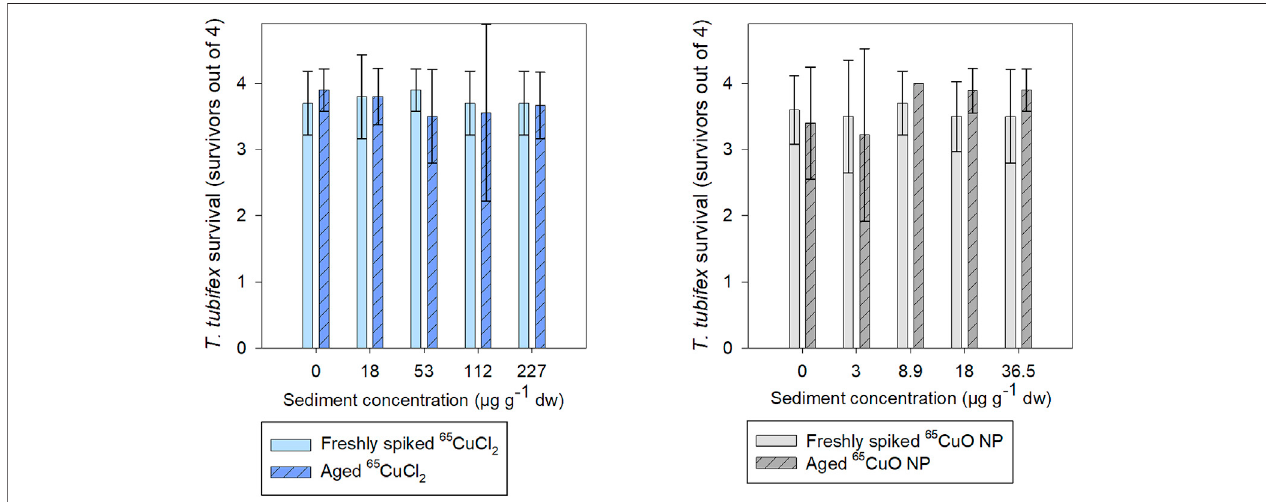
FIGURE 2 | Number of surviving T. tubifex out of four per replicate after exposure in freshly spiked sediment (full bars) or aged sediment (scratched bars). Worms were exposed in sediment with 65 CuCl 2 (blue) or 65 CuO NPs (gray) at fi ve concentrations of 65 CuCl 2 or 65 CuO NPs for 28 days. Bars represent the mean number of surviving worms ± SD, n (cid:1) 10.